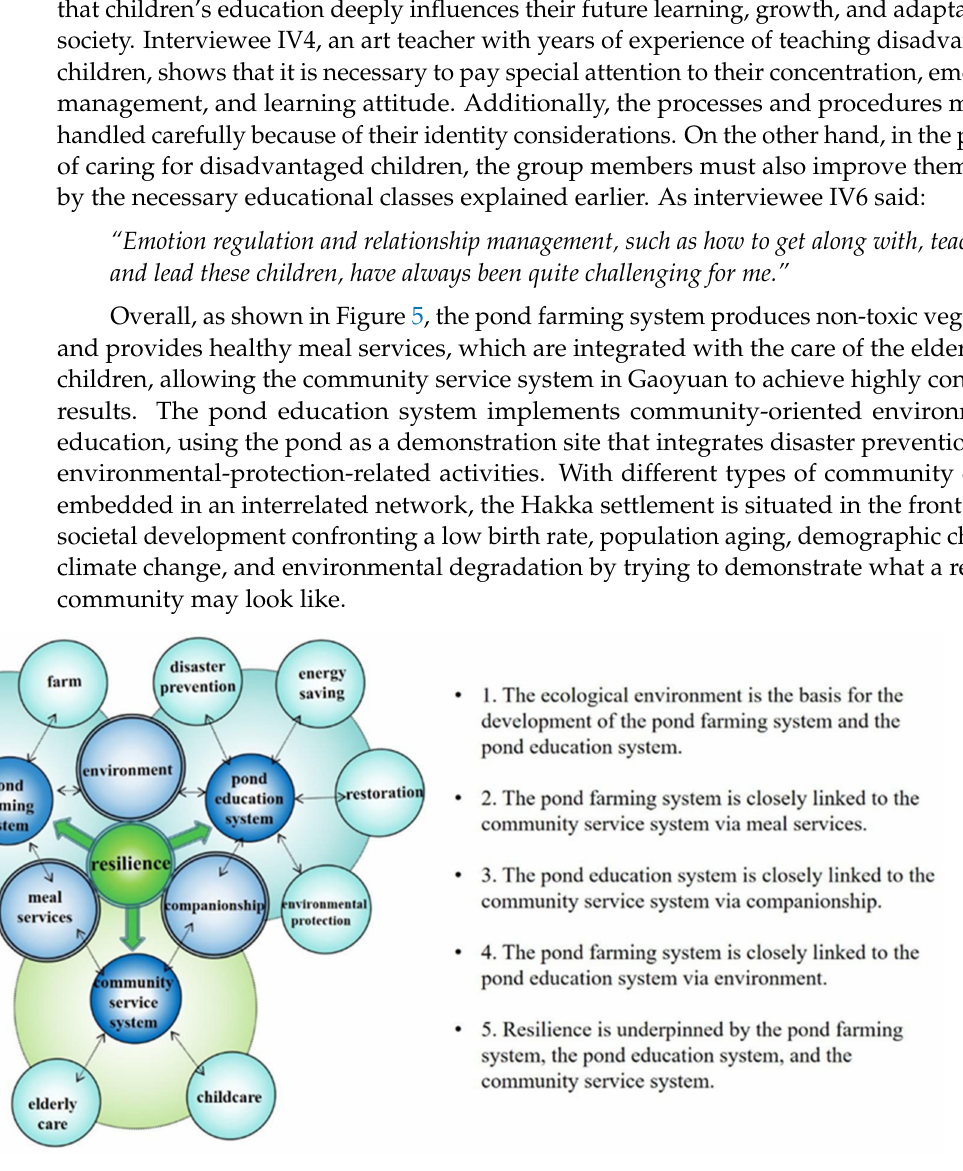
Figure 5. The dynamic, interrelated network of Gaoyuan as a pond-based community seeking to develop